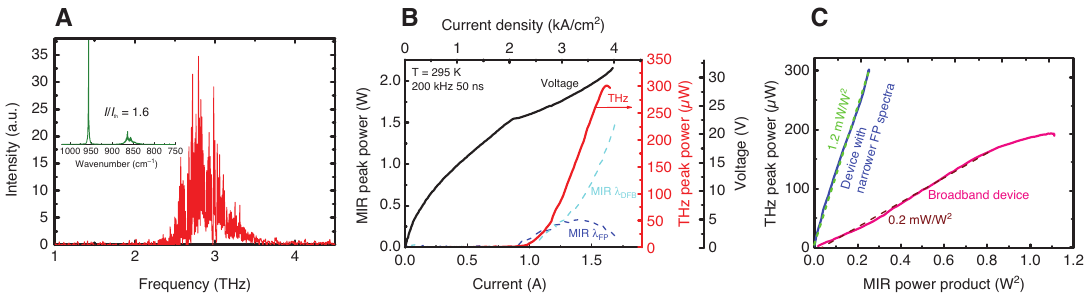
Figure 7: Room-temperature performance of a 3-mm-long, 14- μ m-wide DFG-QCL with a narrower FP pump spectrum [48]. (A) Mid-IR (inset) and THz emission spectra of the device. (B) THz peak power (red solid line), the mid-IR FP and DFB pump powers (dashed lines), and voltage (black solid line) versus current density. (C) Peak THz output powers versus the products of mid-IR pump powers for the narrowband device and the broadband